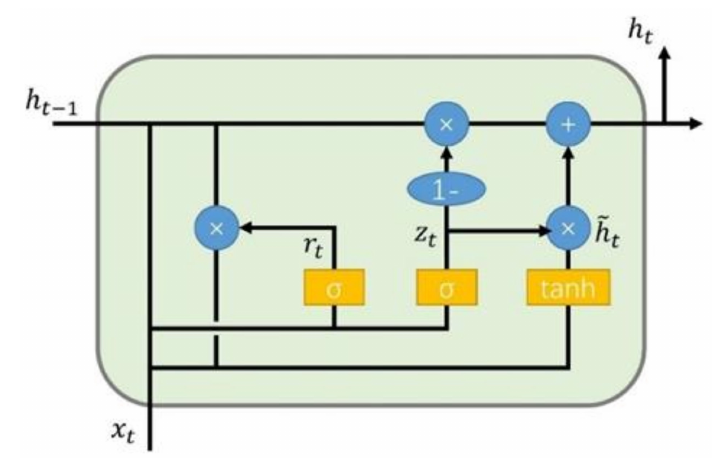
Figure 7. Structure of the gate recurrent unit (GRU)